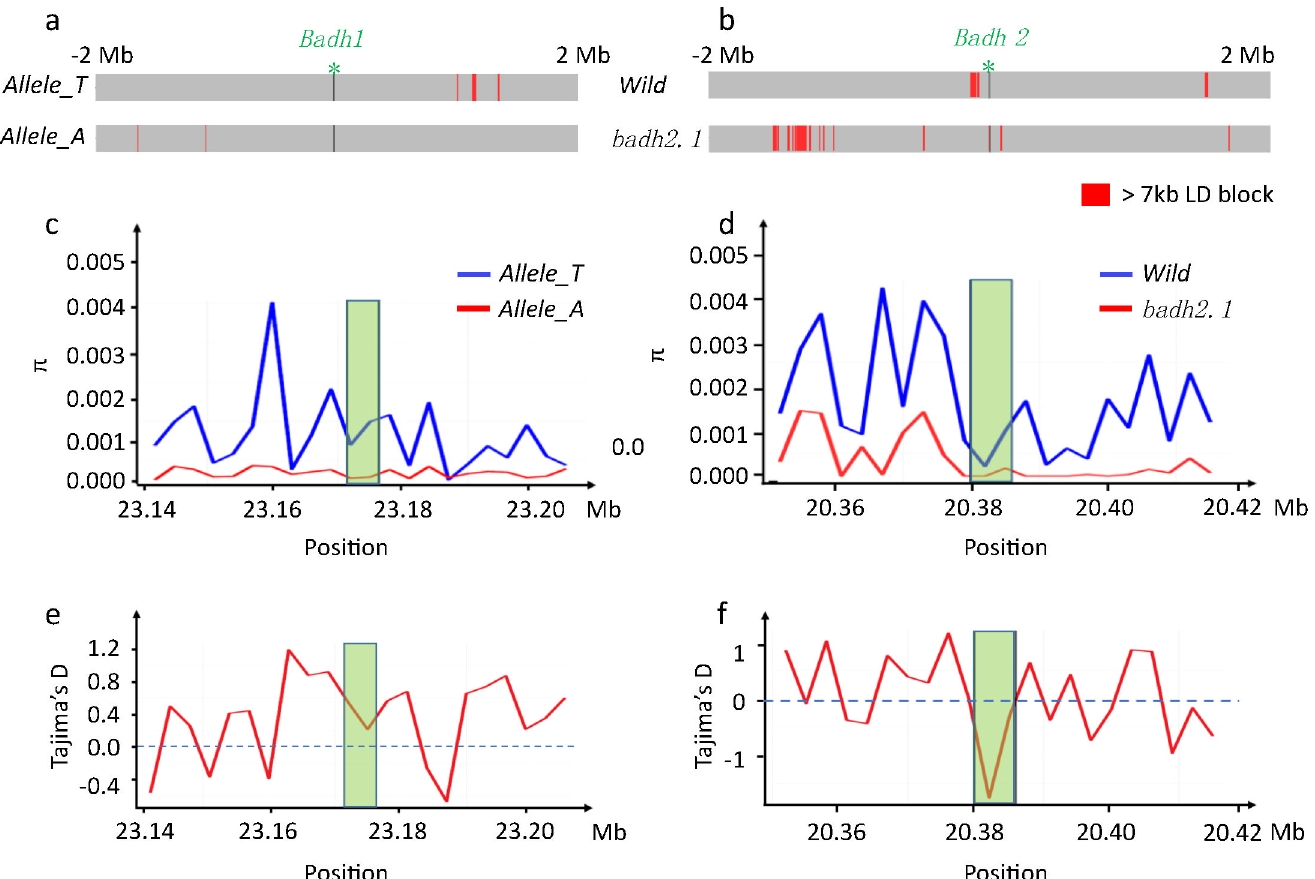
Fig 4. LD block, nucleotide diversity and Tajima ’ s D in BADHs regions (Green part are the gene regions). (a) LD block of BADH1 at different groups. (b) LD block of BADH2 at different groups (badh2.1 has 8bp deletion in exon 7). (c) Nucleotide diversity of BADH1 region with 3kb slide window. (d) Nucleotide diversity of BADH2 region with 3kb slide window. (e) Tajima ’ s D of BADH1 region with 3kb slide window. (f) Tajima ’ s D of BADH2 region with 3kb slide window.